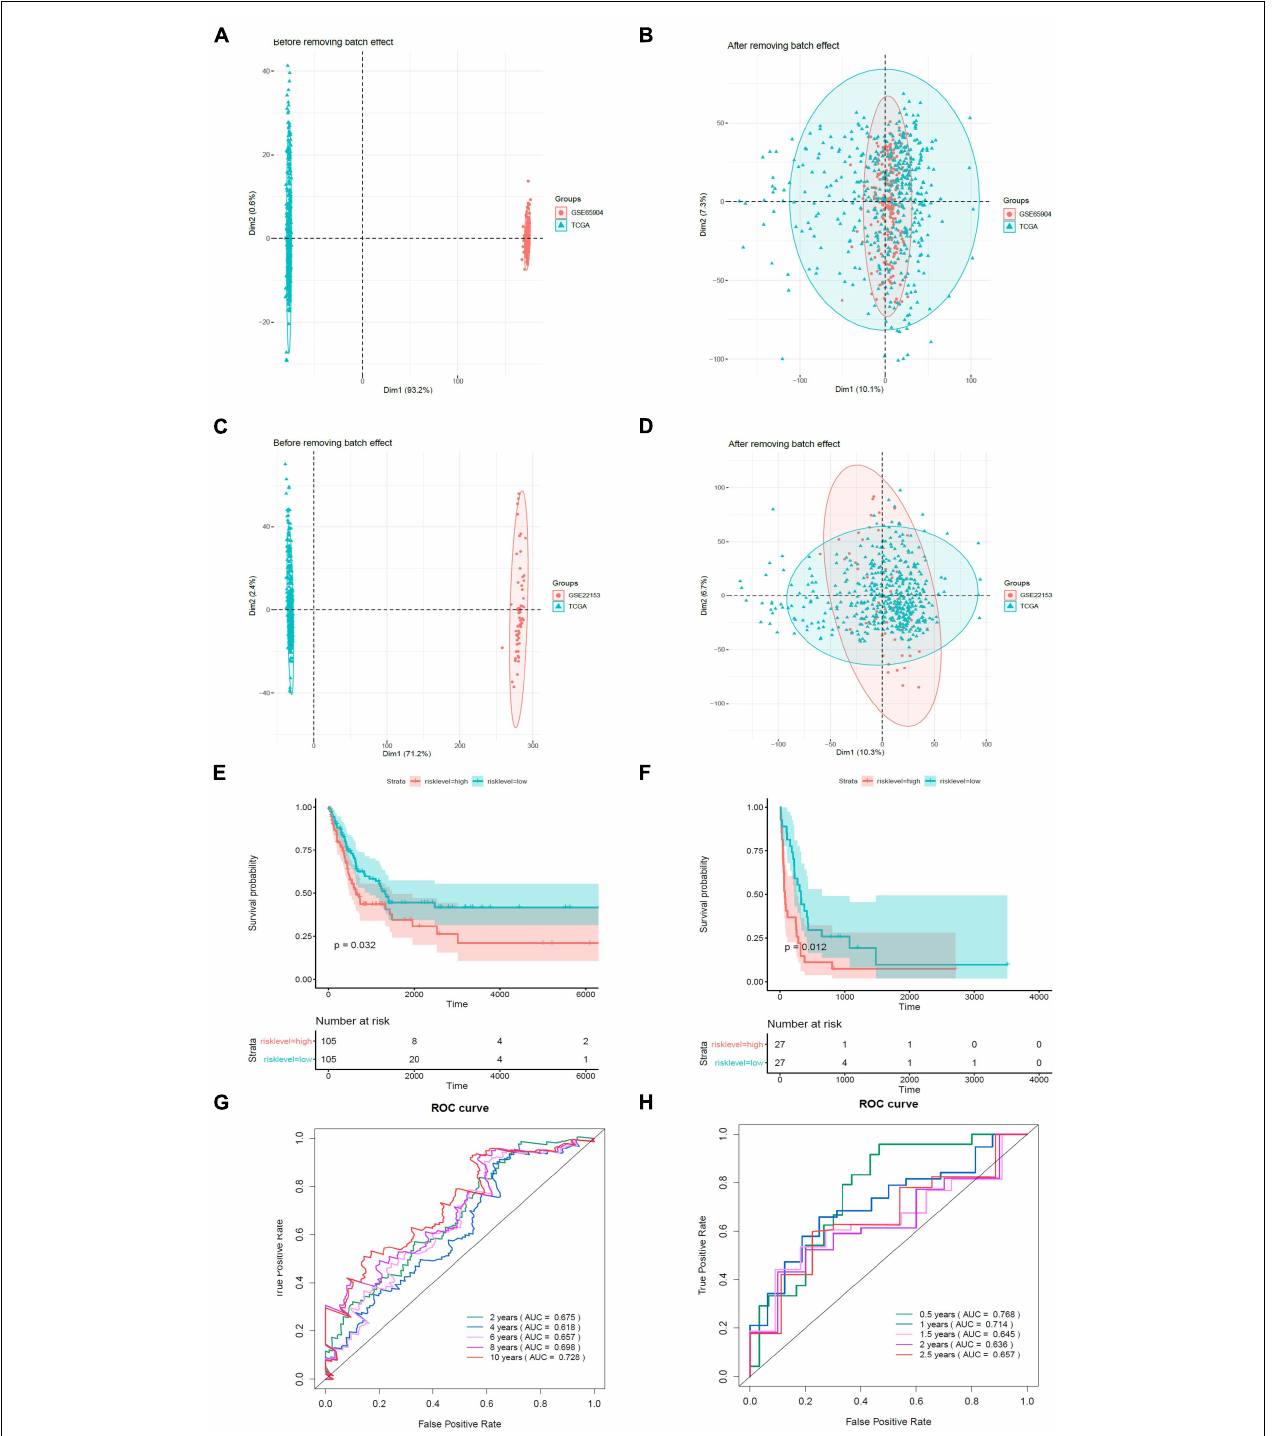
FIGURE 7 | Validation of the prognostic model. (A) PCA analysis before removal of the batch effect between the GSE65904 dataset and the de-batched TCGA data. (B) PCA analysis after removal of the batch effect between the GSE65904 dataset and the de-batched TCGA data. (C) PCA analysis before the removal of batch effect between the GSE22153 dataset and the de-batched TCGA data. (D) PCA analysis after removing the batch effect between the GSE22153 dataset and the de-batched TCGA data. (E) Kaplan–Meier survival curve of GSE65904 dataset. (F) Kaplan–Meier survival curve of GSE22153 dataset. (G) Time-dependent ROC curves in GSE65904. (H) Time-dependent ROC curves in GSE22153.